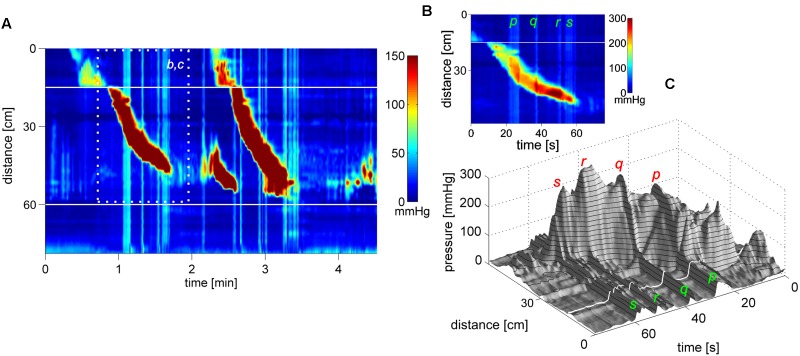
Independent HAPWs and SPWs show addition of pressure. (A) Concomittant occurrence of HAPWs and SPWs. The anal sphincter pressure is not shown. (B) A closeup of one of the HAPWs with unrelated SPWs. (C) The 3D graph of (A) shows that the pressures of the HAPW and the SPWs add up. This activity started 8 min after injecting 20 mg bisacodyl suspension in the descending colon. There was no outflow felt.